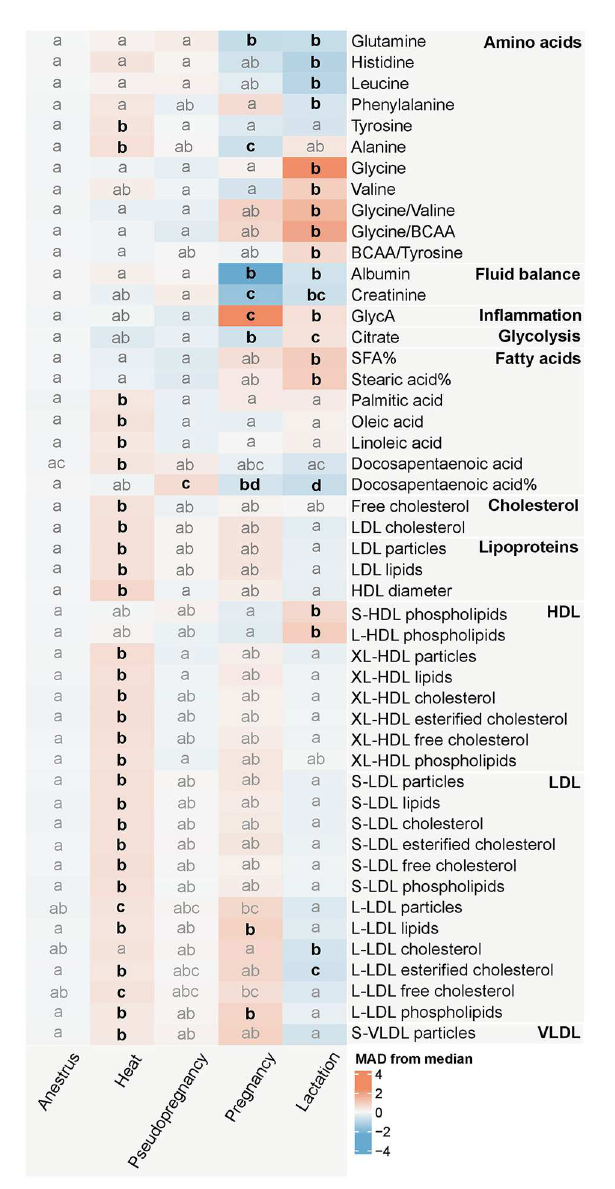
FIGURE3 Heatmap of the measurands significantly ( p < 0.0026) associated with the reproductive state in the Kruskal-Wallis test. The colors represent the median of each reproductive state group in median absolute deviation (MAD) scaled data. The intensity of the color increases proportionally with the magnitude each reproductive state differs from the overall median metabolite value. The change in magnitude is expressed as the amount of MAD:s the median of each reproductive state group differs from the overall median of the metabolite. Blue hues indicate that the median MAD of the group is lower, and red hues indicate that the median MAD of the group is higher than the overall median of the dataset. The letters indicate similarity of groups: groups with the same letters do not differ significantly from each other, whereas groups with different letters differ significantly ( p < 0.05) from each other for the metabolite in question in the Dunn’s test with Bonferroni correction, which was performed as a post-hoc test for the Kruskal-Wallis test. Emboldened, black letters indicate significant differences from anestrus. Anestrus n = 663, heat n = 78, pseudopregnancy n = 43, pregnancy n = 15, lactation n = 38.